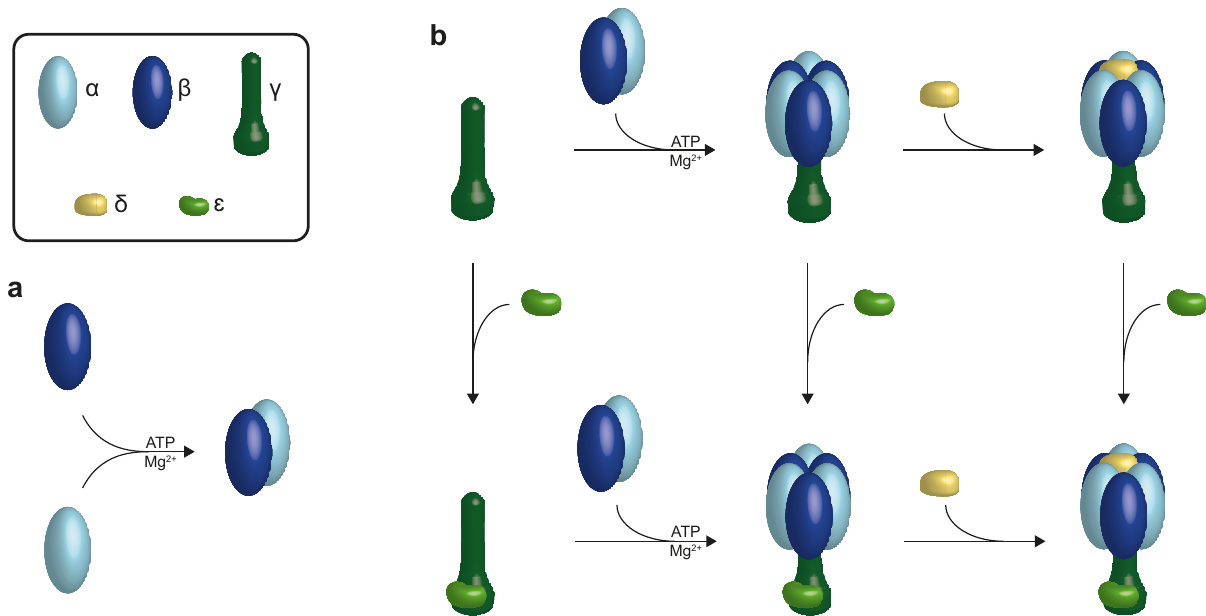
Fig. 8 Order of assembly steps into bacterial F 1 . a As a fi rst step α -subunits (light blue) and β -subunits (dark blue) form αβ heterodimers, which requires the presence of nucleotides and Mg 2 + . b As next step three of these heterodimer building blocks assemble pairwise to the central stalk γ (dark green). Only after the formation of the full hexameric head, the δ -subunit (yellow) is able to bind. The ε -subunit (light green) can join into the assembly process at all intermediate step en-route to the F 1